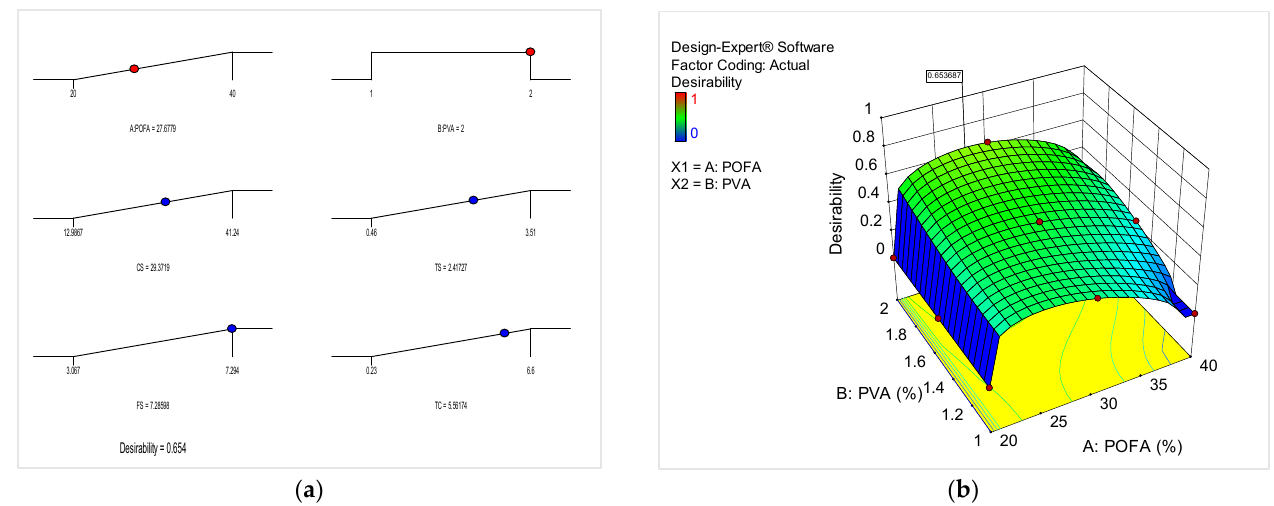
Figure 24. ( a ) Optimization solution ramps ( b ) 3D response surface plot for the optimization desirability.